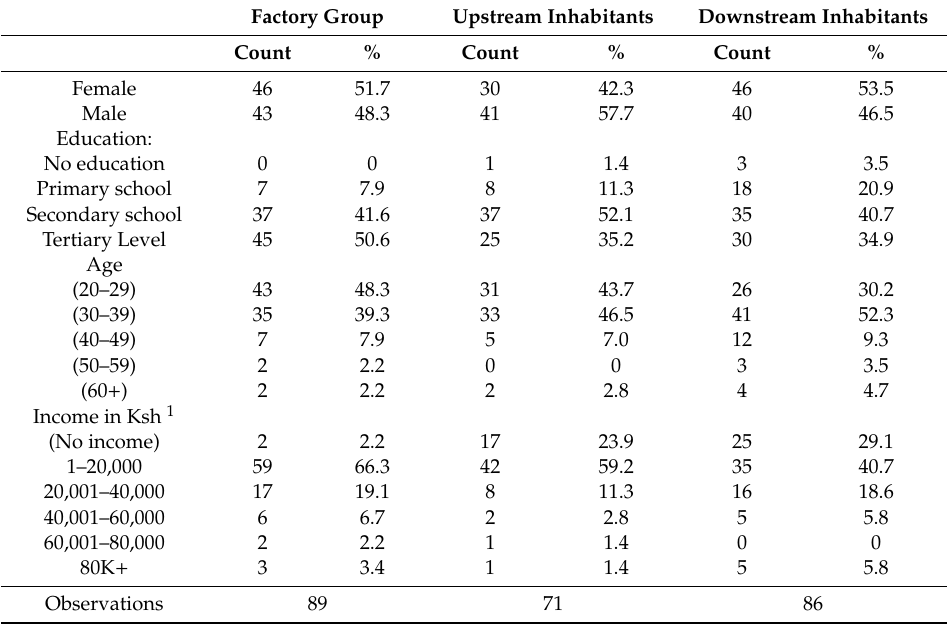
Table 1. Summary statistics of demographic